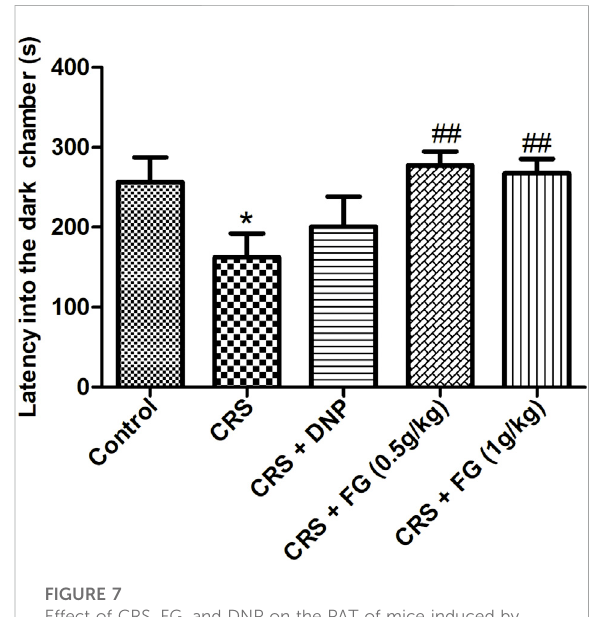
FIGURE 7 Effect of CRS, FG, and DNP on the PAT of mice induced by CRS. Values represent the mean ± S.E.M. n = 8 ~ 10 mice/group. * p < 0.05 compared with the control group; ## p < 0.01 compared with the CRS group.